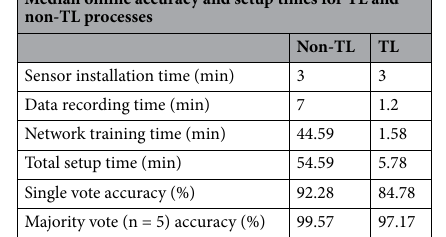
Table 1. Transfer learning setup time improvements for subsequent